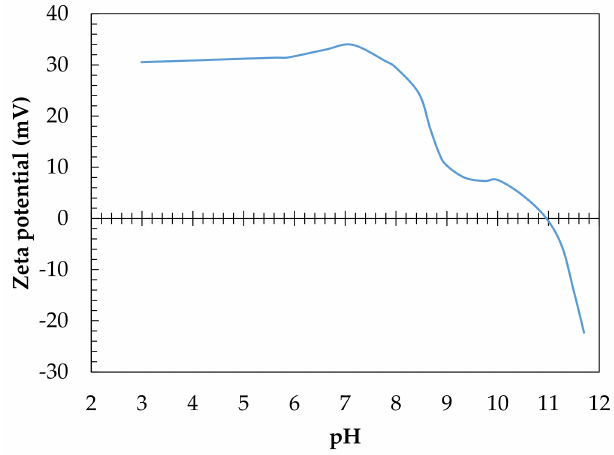
Figure 3. Evolution of the GAC’s zeta potential at different pH